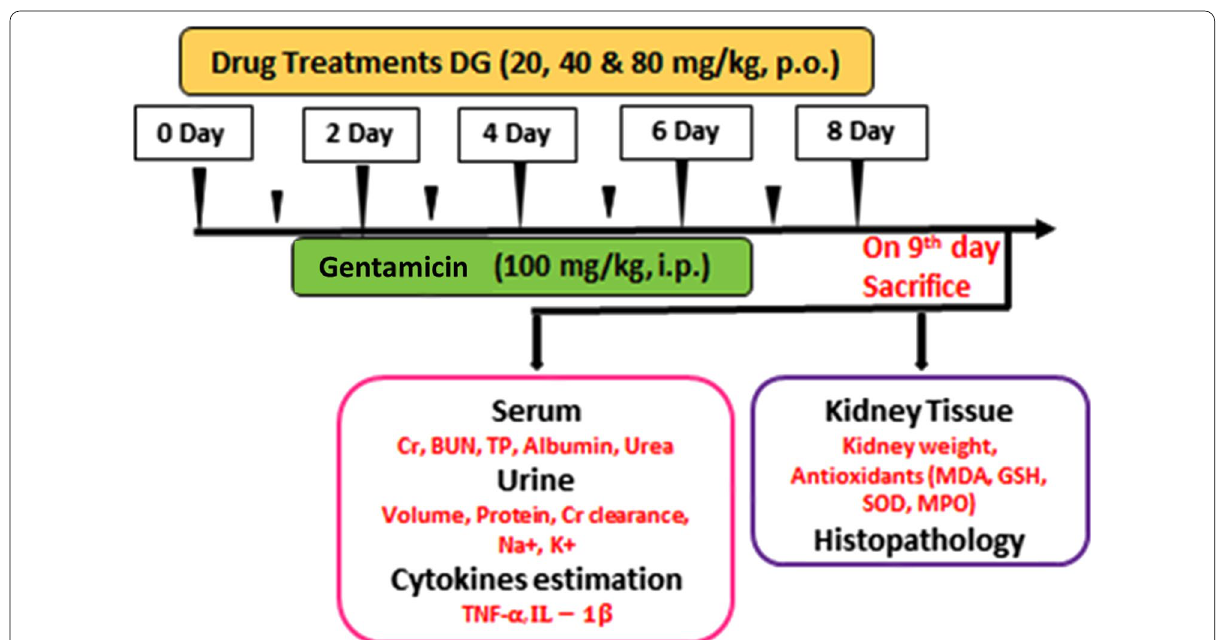
Fig. 2 Schematic representation of the induction of GM induced nephrotoxicity and drug treatment in